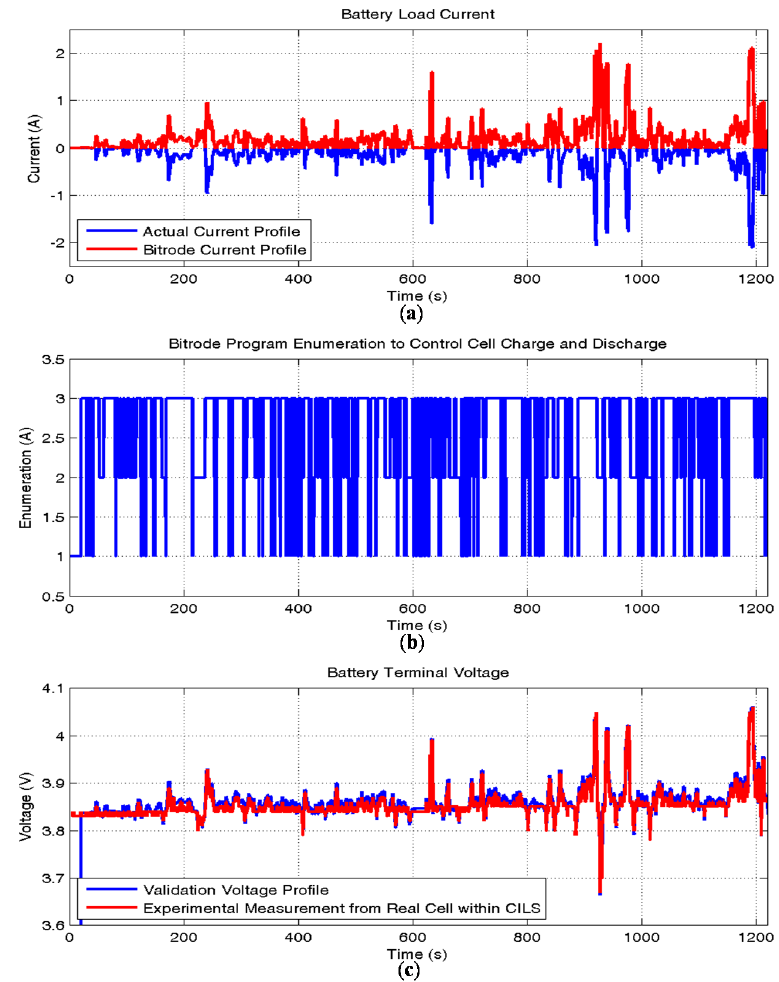
Figure 7. Validation of the ECM and CILS environment for real-time testing: ( a ) battery load current; ( b ) current control signal; ( c ) battery terminal